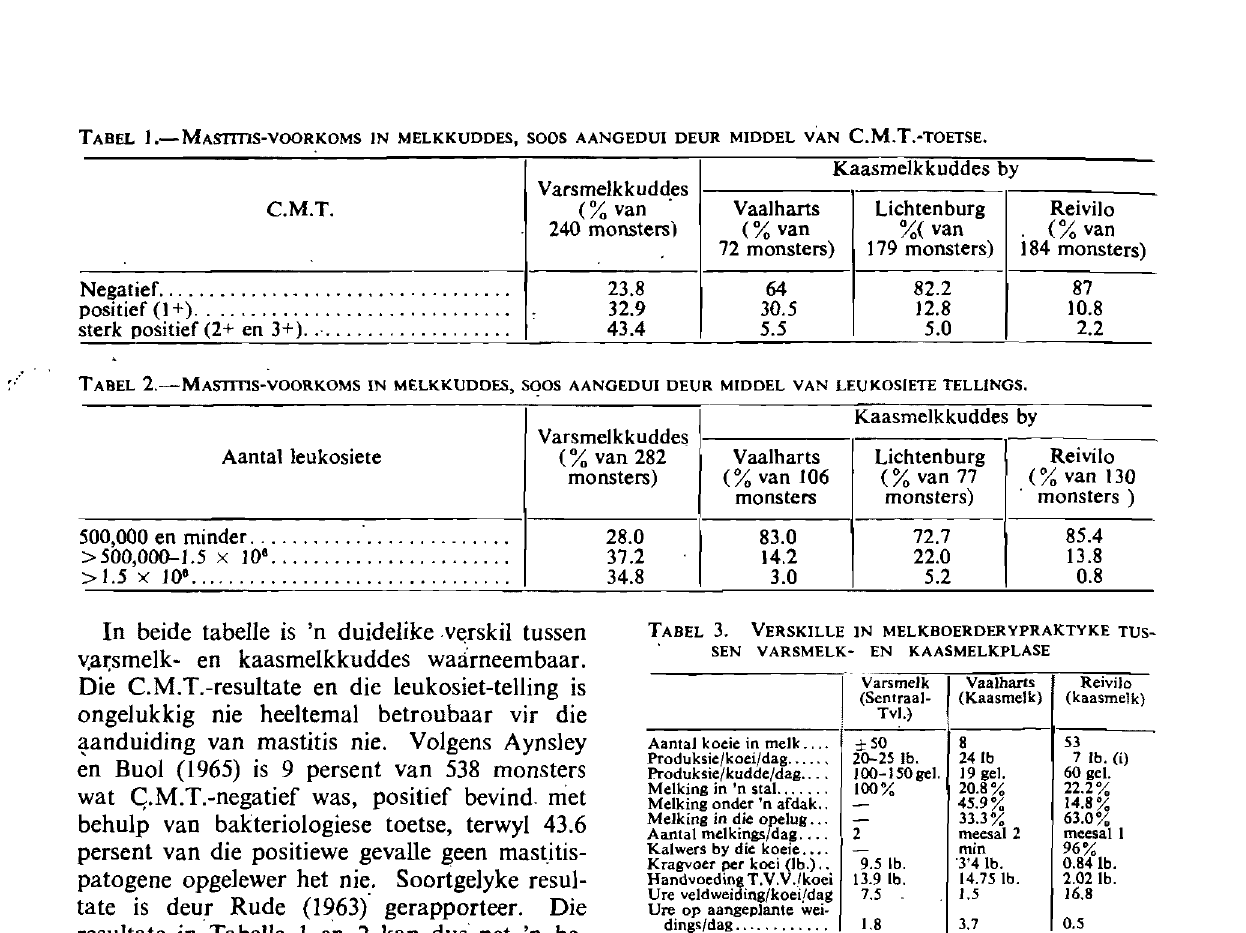
. Toestande in elie Lichtenburg-area korn min of rneer ooreen met d!e' by Reivilo, alhoewel die kuddes kleiner is cn minder kalwers nag aan die koeie suip. kry heelwat kragvoer. By Vaalharts is die plasies klein en die boerdery ook relatief inten sief. By Reivilo, daarenteen is die boerdery baie ekstensief van aard en die koeie word ge~ woonlik eenmaal per dag vanaf die weidings gemelk. Mastitis word met verskillende faktore ge assosieer so as voedingskondisies, klimaat, hi gieniese praktyke, seisoen van die jaar, stadium van laktasie, melkopbrengs, ens. Daar is egter hee1wat teenstrydige getuienis in hierdie ver band. Sommige werkers het by. 'n verwantskap gevind tussen hoe opbrengs en mastitis, terwyl andere hierdie bevindinge nie kan bevestig nie (Sien Fell, 1964). Met die eerste oogopslag wil hier 'n ro1 spee1. Die hoe opbrengs van die koeie in Vaalharts spreek egter daarteen,